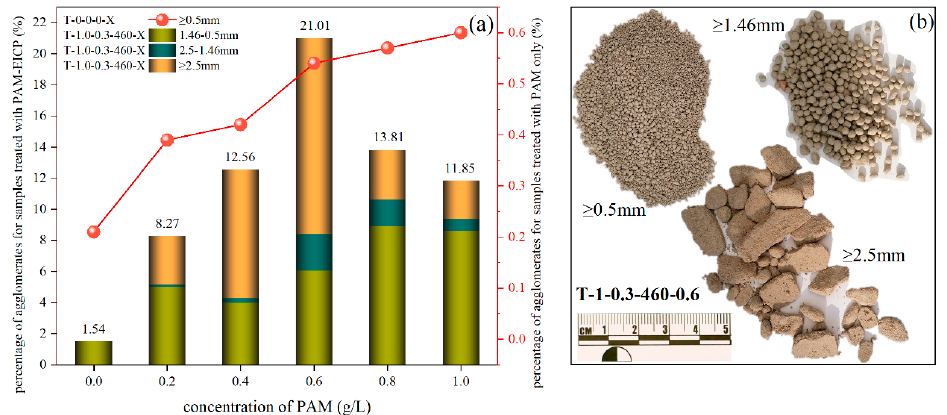
Figure 3. Percentage of agglomerates (i.e., the particle size of the FA was equal to or more than 0.5 mm) in the total mass of the samples cured with different treatment solutions. ( a ) with the increase in the PAM concentration, the percentage of agglomerated particles ( ≥ 0.5 mm) showed an increasing trend, dot-line diagram for the samples treated by PAM, column graph for the samples treated by PAM-EICP; ( b ) particle size of sample T-1-0.3-460-0.6 after sieving.